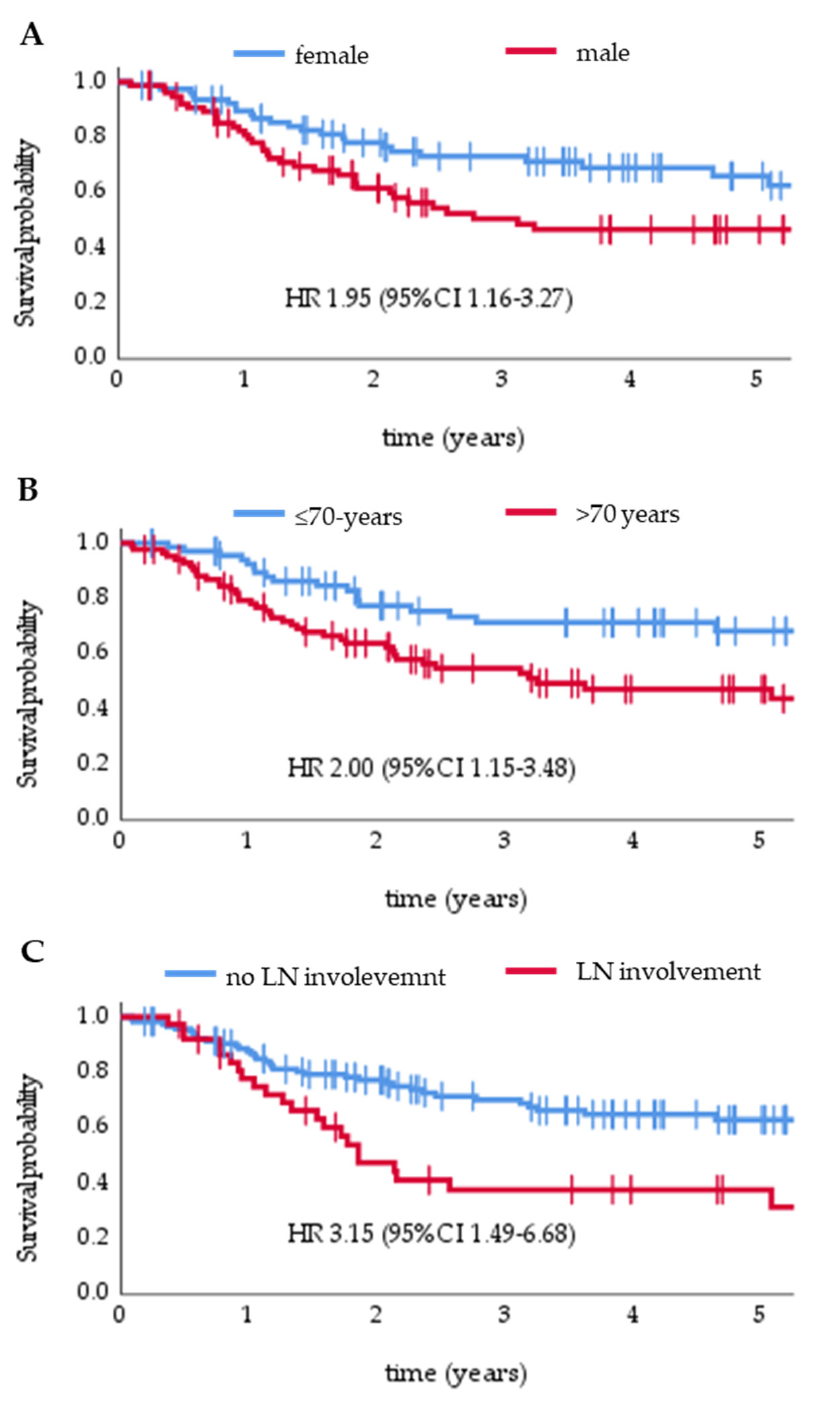
Figure 4. Overall survival is stratified by gender ( A ), age ( B ), and lymph nodes (LN) involvement at diagnosis ( C ).